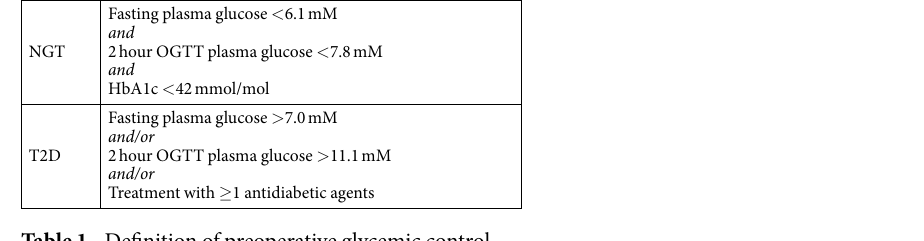
Table 1. Definition of preoperative glycemic